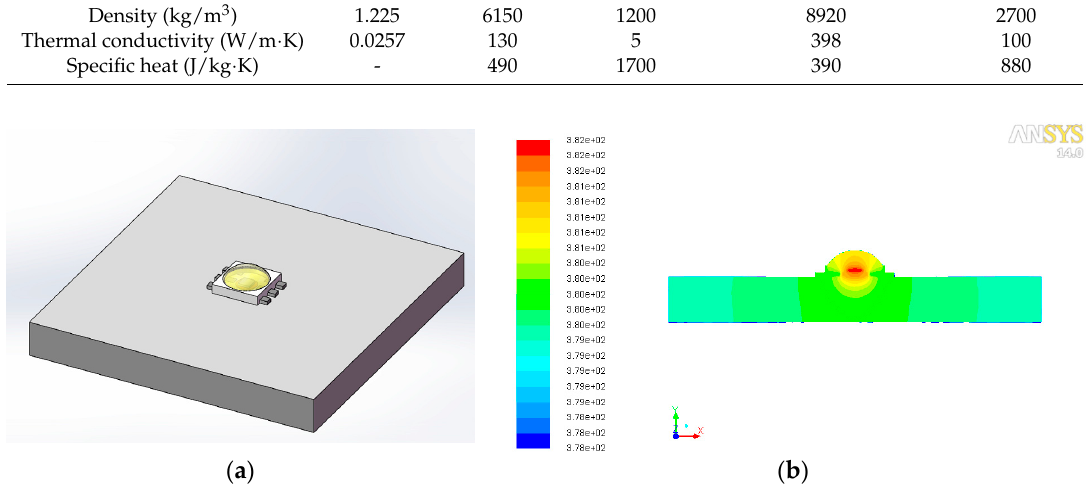
Figure 9. ( a ) The 3D model of test sample soldered on a substrate used for FEA simulation; ( b ) its simulated Kelvin temperature distribution.